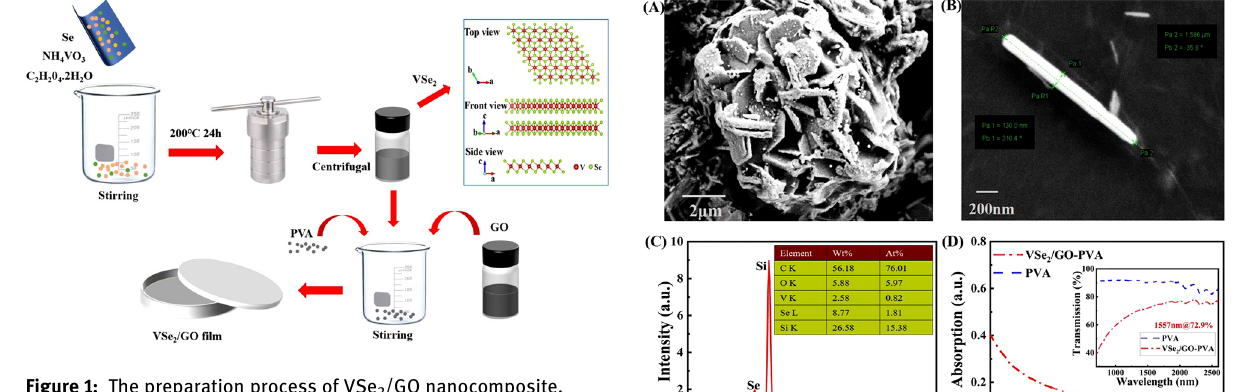
Figure 1: The preparation process of VSe 2 /GO nanocomposite.